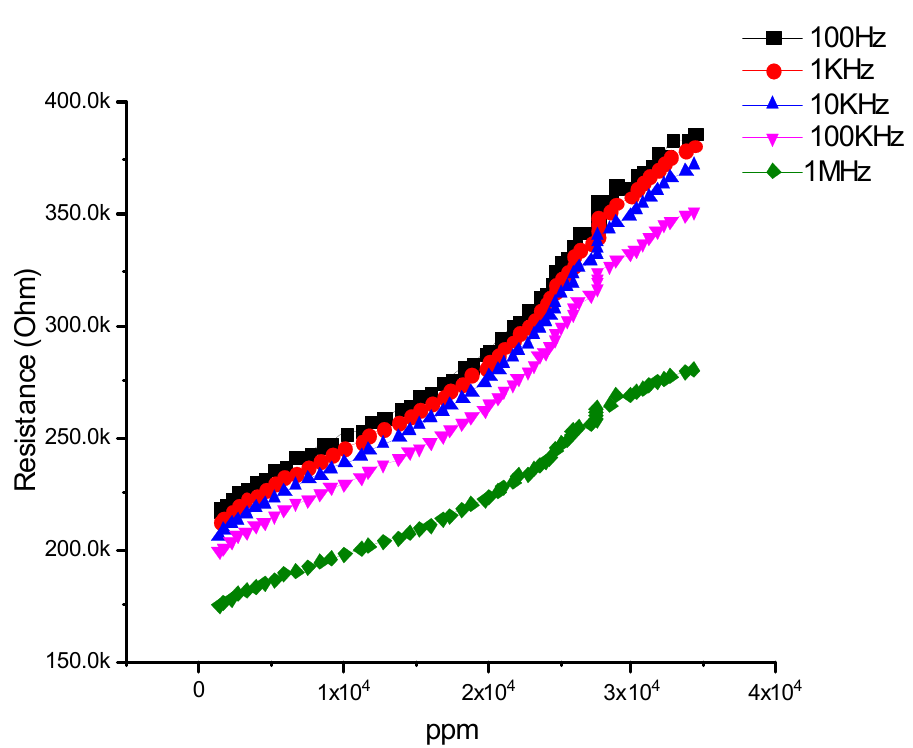
Figure 7. Resistance (ohm) vs. concentration of ammonia (ppm).